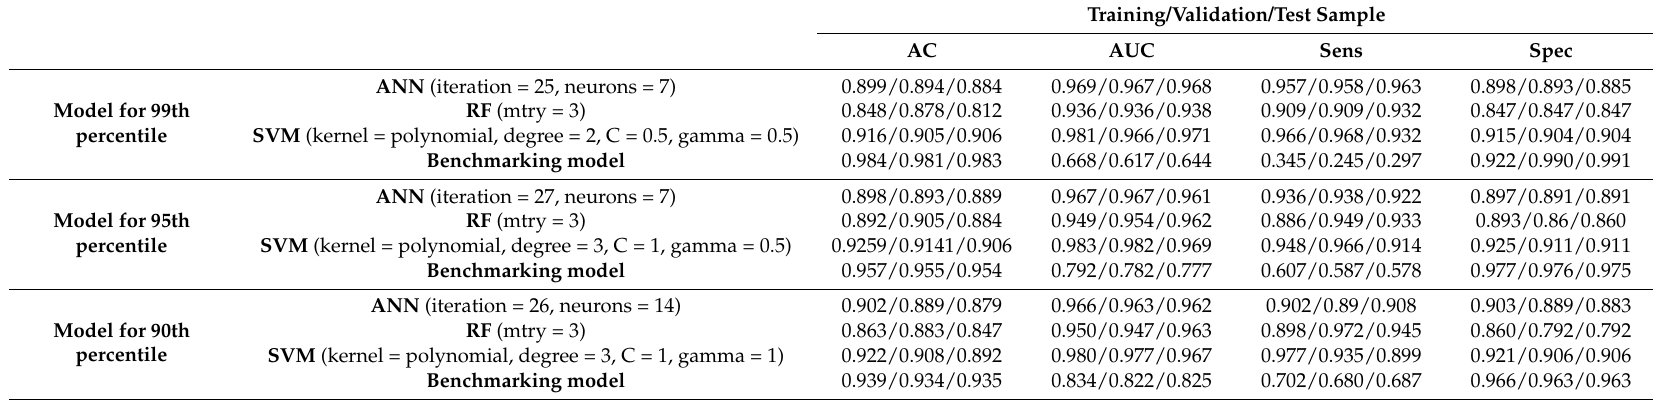
Table 8. Peak classification results of the machine learning algorithms. AC: accuracy; ANN: artificial neural network; RF: random forest; SVM: support vector